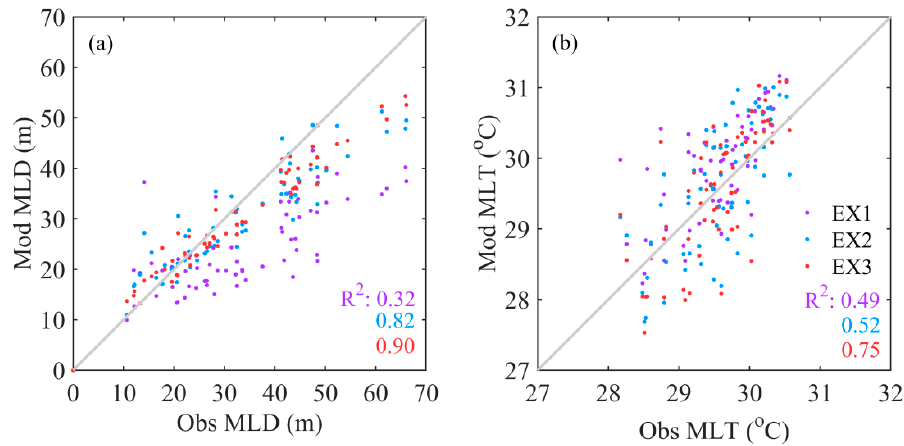
Figure 10. Scatterplots of MLD ( a ) and MLT ( b ) between Argo float observations and numerical experiments with the related linear best-fit lines. Observations are from floats within the TC-a ff ected area during TC. The observed locations are shown in Figure 1b and the number of data is 69. Table 4. Comparisons of the MLD and MLT between the Argo and numerical experiments during the TC.